Question: How would you classify this visualization?
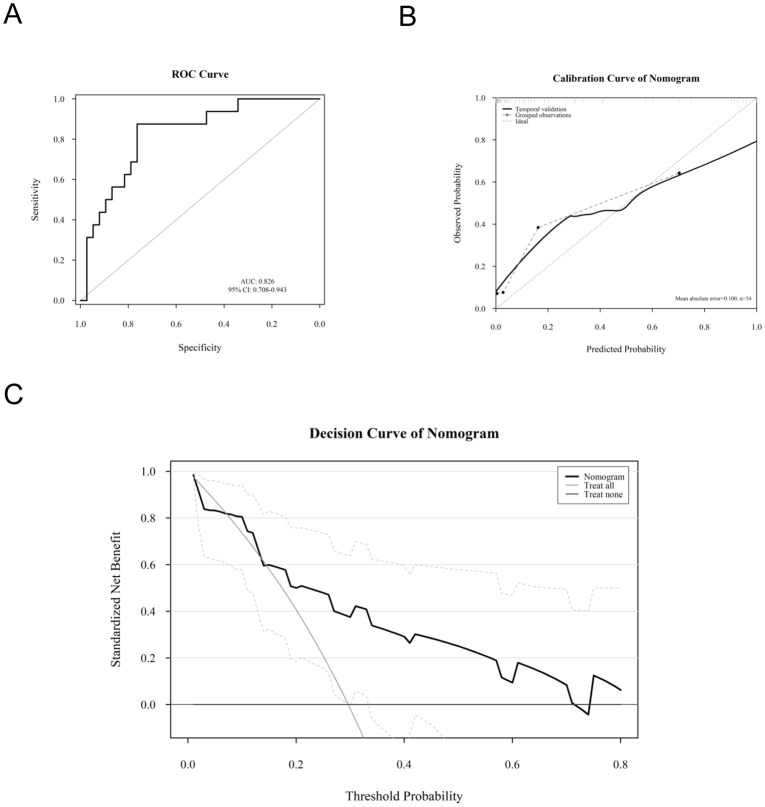
Answer: line